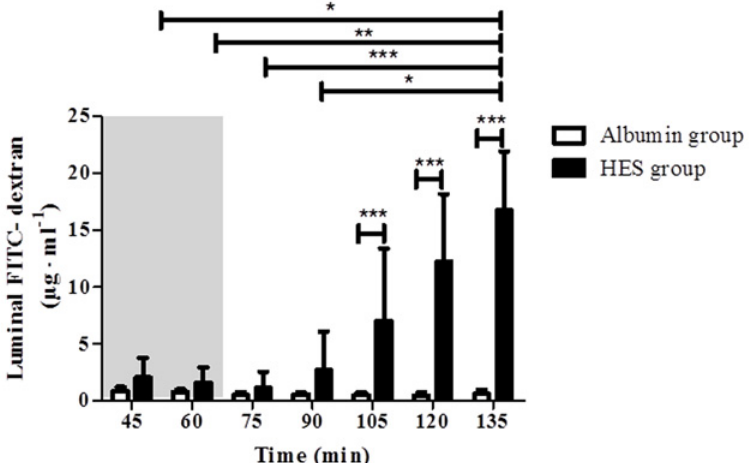
Fig 4. Luminal FITC-dextran concentrations. Luminal FITC-dextran concentrations were evaluated every 15 minutes and sufficient amounts of effluents for analyses were obtained at time point 45 min and beyond. Areas shaded in grey indicate the equilibration phase. Error bars denote the mean ± SD. Albumin (N = 7), HES (N = 7). * , p < 0.05; ** , p < 0.01; *** , p < 0.001.